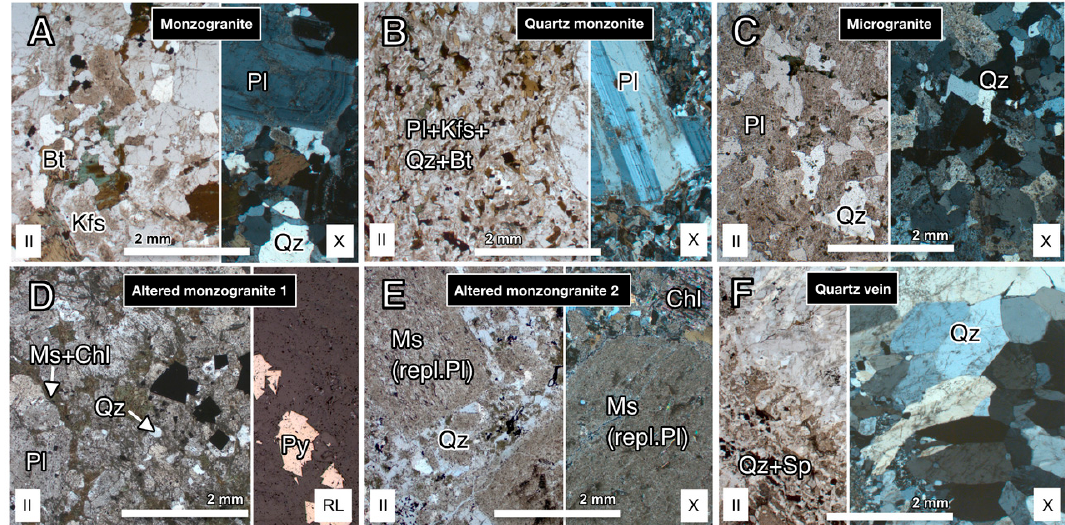
Figure 4. Photomicrographs of representative samples from the NW part of the Naundorf quarry. ( A ) Monzogranite; ( B ) Quartz monzogranite; ( C ) Microgranite; ( D ) Altered monzogranite 1; ( E ) Altered monzogranite 2; ( F ) Quartz vein. Abbreviations are as follows: II—plane polarized light, X—cross-polarized light, RL—reflected light. Mineral abbreviations after [98].